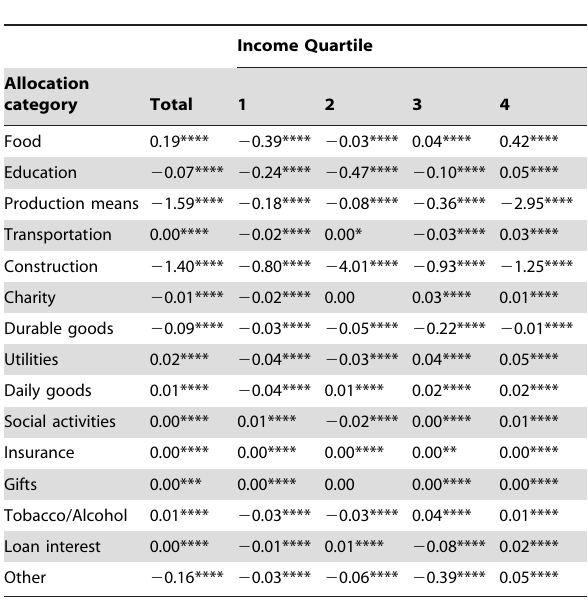
Table 6. Impact of health expenses on household allocation patterns: a 1% increase in health expenditure is associated with __% change in consumption